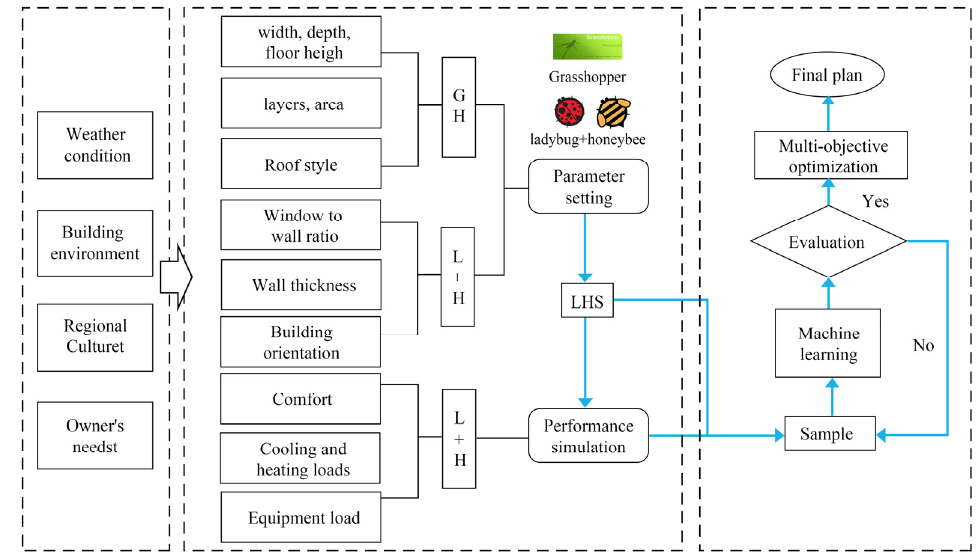
Figure 1. Flow chart of generation and optimization of detached energy-saving houses.